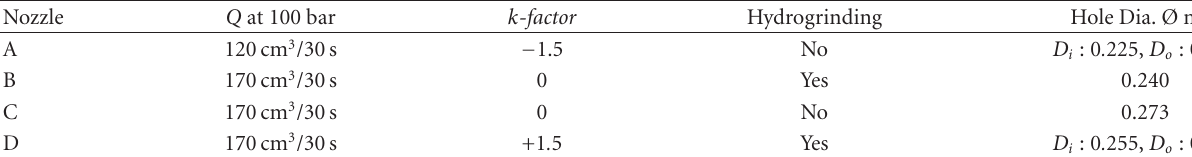
Table 1: Nozzle properties (manufacturer’s data).